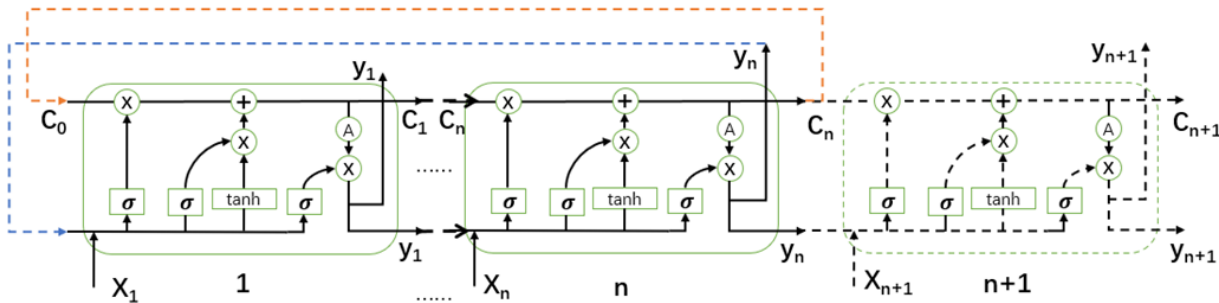
Figure 4. Stack-LSTM model structure diagram.